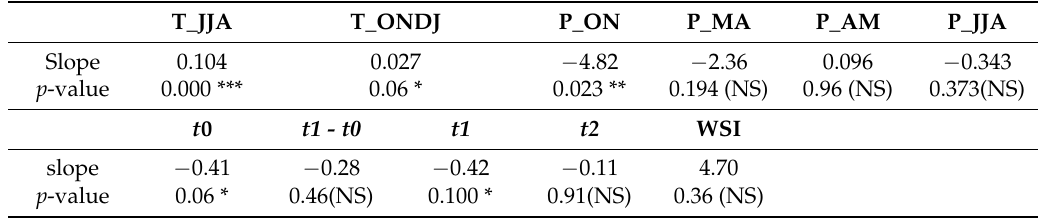
Table 5. Temporal trend in climate variables (temperatures for June, July, and August (T_JJA), October, November, December, and January (T_ONDJ)), precipitations for October and November (P_ON), March and April (P_MA), April and May (P_AM), and June, July, and August (P_JJA), and the